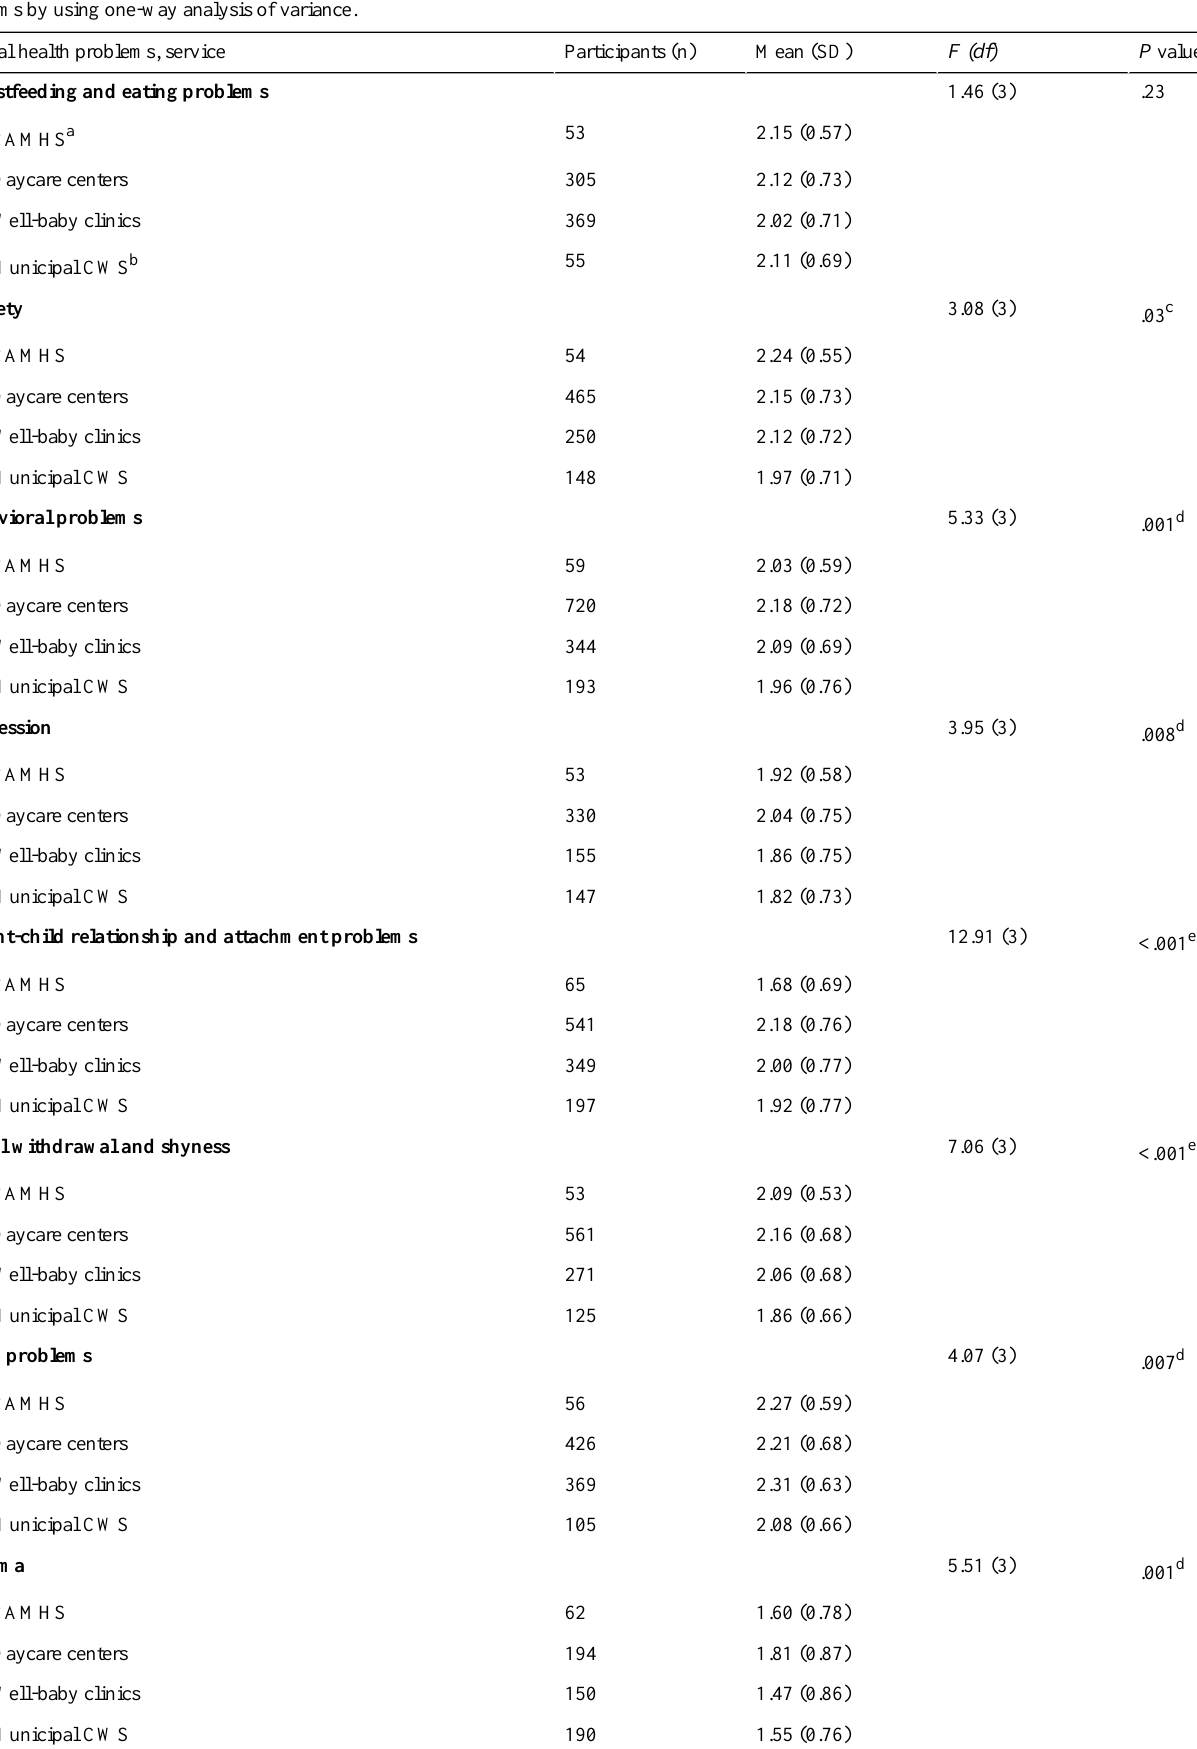
Table 4. Comparisons of the perceived usefulness of internet-based interventions by different services for 12 different infant and child mental health problems by using one-way analysis of